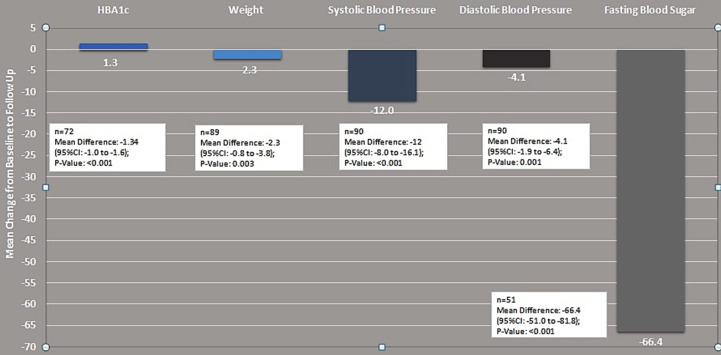
Effect of SGLT2 Inhibitors.(Empagliflozin & Dapagliflozin) on Systolic Blood Pressure, Diastolic Blood Pressure, Weight, Fasting, Blood Sugar, Random Sugar from to Follow Up.